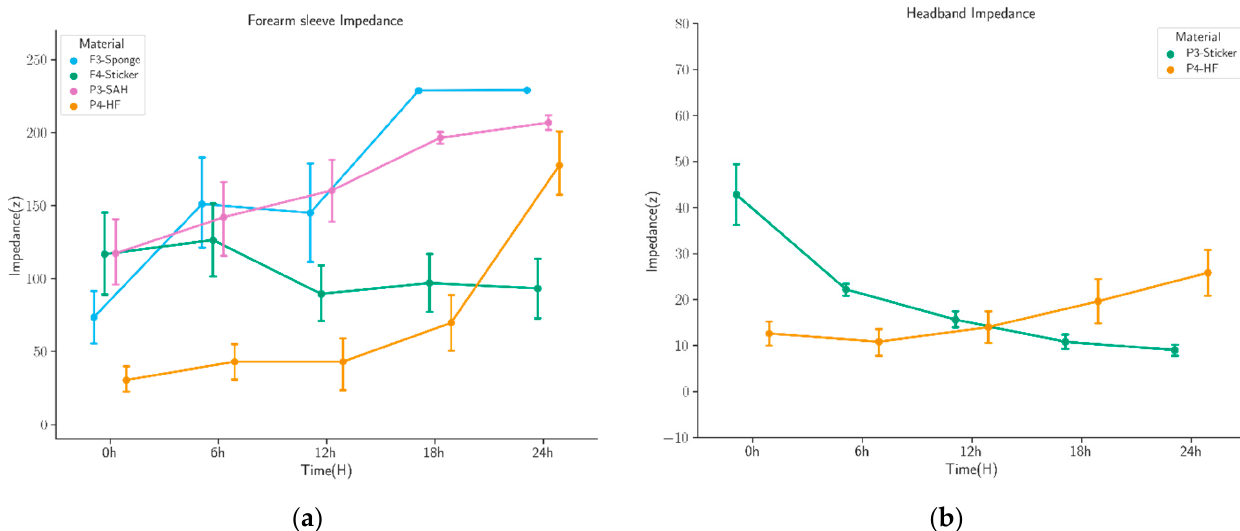
Figure 6. Impedance mean values of skin–electrode interface materials on the electrode–scalp impedance by measuring the 10 Hz impedance at the armband and headband. ( a ) The electrode– scalp impedance of the sponge, sticker, SAH, and HF overall measurements on the forearm sleeve. ( b ) The electrode–scalp impedance of the sticker and HF overall measurements on the headband.